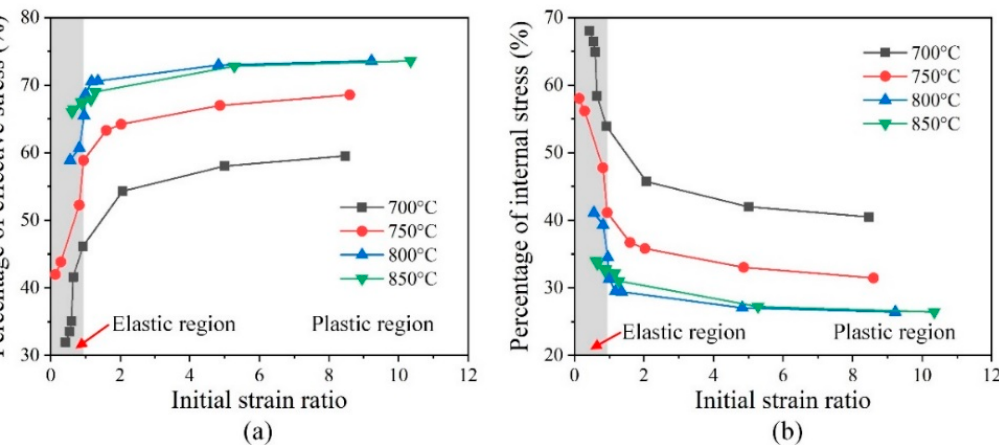
Figure 6. Variations in stress components of Ti-6Al-4V alloys with different initial strain ratios at indicated temperatures, ( a ) percentage of effective stress (defined as the ratio of effective stress to flow stress), ( b ) percentage of internal stress (defined as the ratio of internal stress to flow stress). The apparent activation energy Q a strongly affected by temperature and stress condi- tions can be used to speculate the evolution trend of the creep mechanism in the SR process.